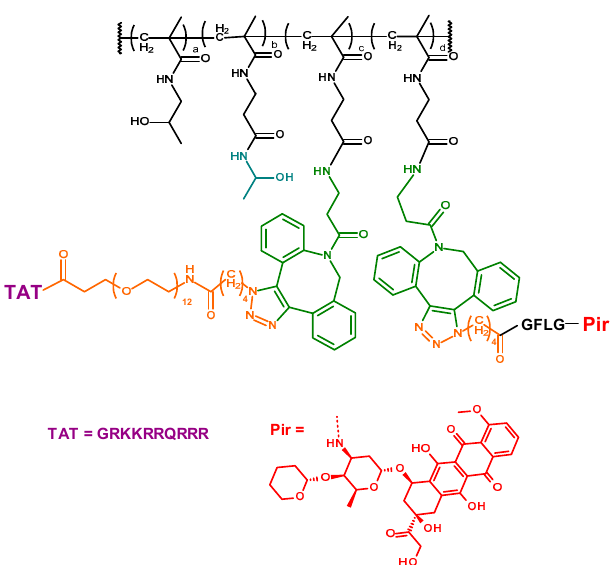
Figure A1. Scheme of pirarubicin bearing polymer–peptide conjugate P-T12-Pir . Pharmaceutics 2020 , 12 , x